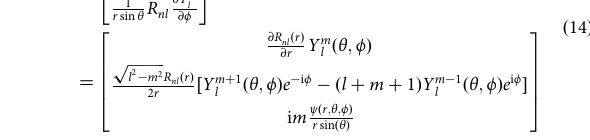
plotted in Fig. 6c showing maximum and minimum overlap with a plaquette atom con fi ned at 176 nm. The interaction of 1 c with global dynamical decoupling (DD) sequences such as WAHUHA 114 .